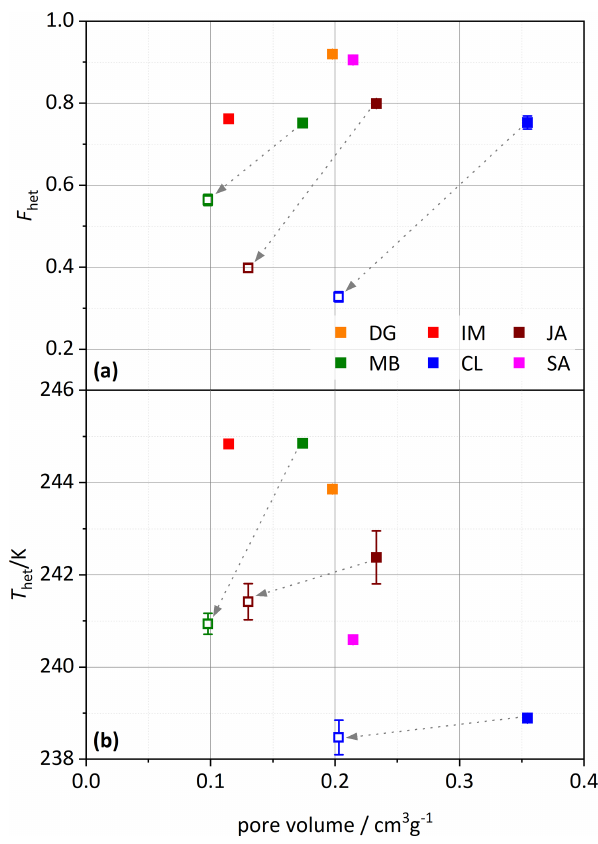
Figure 11. (a) Heterogeneously frozen fraction, F het , and (b) het- erogeneous freezing onset temperature, T het , plotted against the spe- cific pore volume calculated from DVS measurements (analyzed be- tween 40%–98% RH). Filled symbols depict untreated samples, and open symbols are milled samples. The dashed arrows point from the untreated to the corresponding milled sample. Dust sample codes are identical to those in Fig. 2.